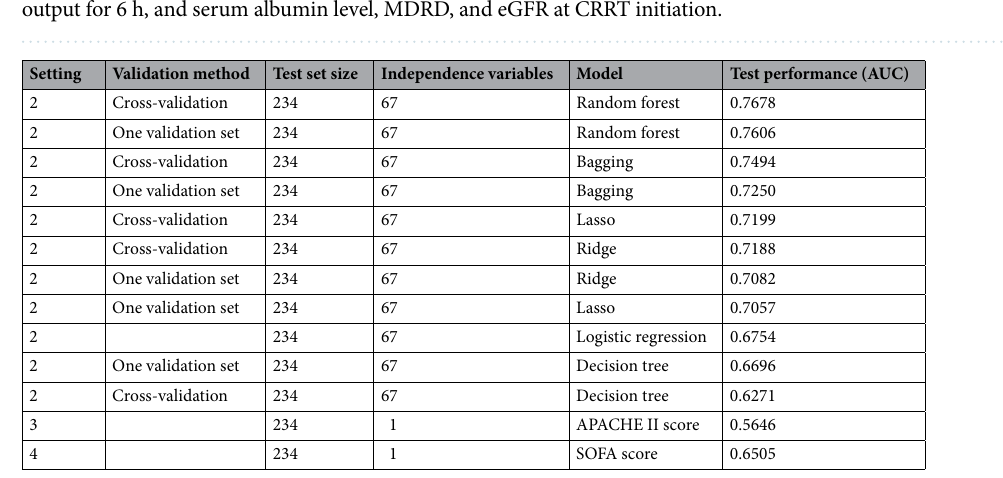
Table 4. Classification model for mortality using the conventional algorithm. AUC area under the curve, APACHE II acute physiology and chronic health evaluation II, SOFA sequential organ failure assessment.